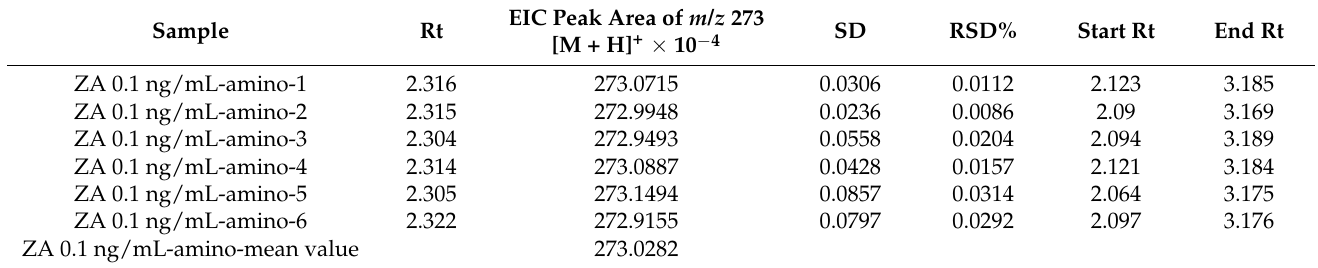
Table 1. Data confirming the precision of the analytical method used (for 0.1 ng ZA/mL standard solution).